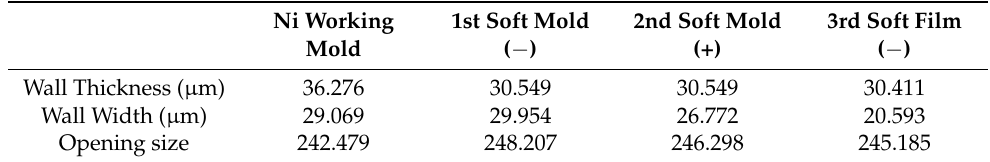
Table 1. Evaluation of size change according to the molding